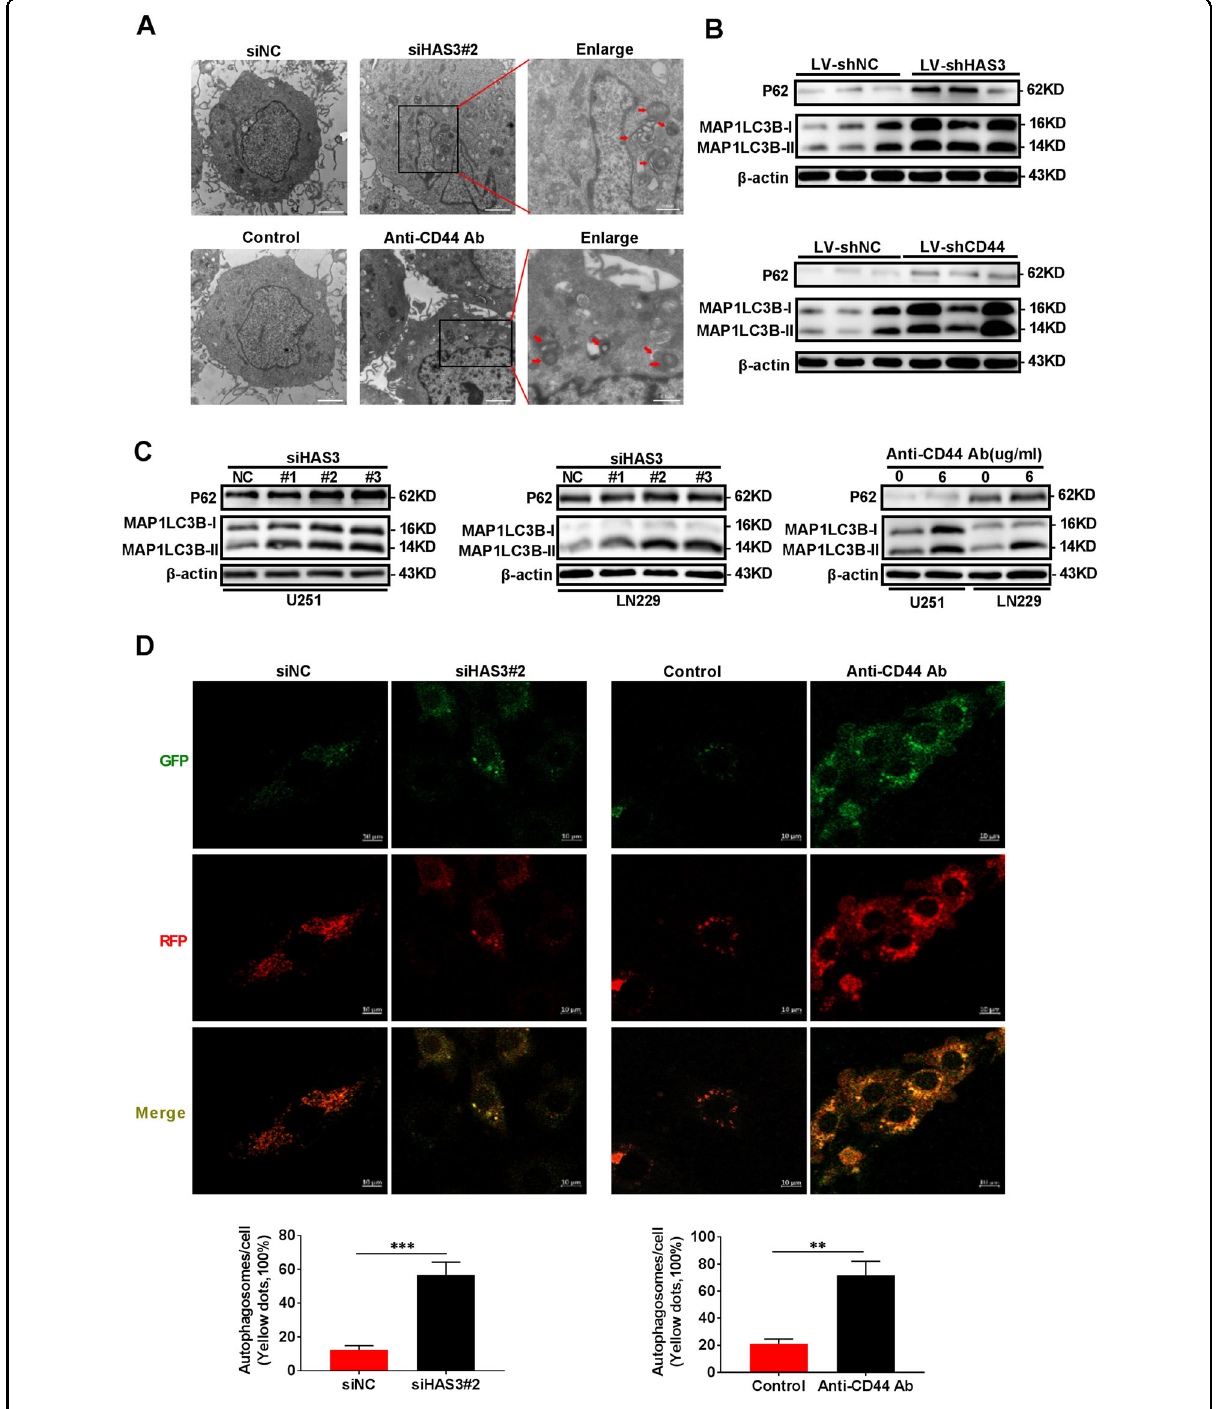
Fig. 3 Treatments interfering with HAS3 and CD44 block autophagy fl ux in vitro and in vivo. A TEM images of U251 glioma cells transfected with the HAS3 siRNA or treated with a CD44 antibody for 48 h. The scale bars represent 2 μ m in the original image, and the scale bars represent 0.8 μ m in the enlarged image. B Relative levels of the P62 and MAP1LC3B proteins in the orthotopic xenograft tumors from the control and lentivirus HAS3 shRNA or lentivirus CD44 shRNA stably transfected glioma cell groups. C Relative levels of the P62 and MAP1LC3B proteins in U251 and LN229 glioma cells transfected with the HAS3 siRNA or treated with a CD44 antibody for 48 h. D Results of the GFP-RFP-LC3 fl uorescence assay using U251 glioma cells transfected with the HAS3 siRNA or treated with a CD44 antibody for 48 h. Scale bar: 10 μ m. The data are presented as the mean ± SD; * P < 0.05, ** P < 0.01, and *** P < 0.001, **** P <